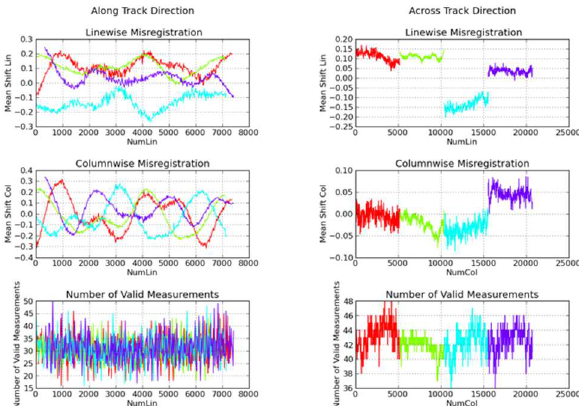
Figure 8 Misregistration profiles of FR-LQ1 image obtained with an attitude correction involving a 5 degrees polynomial function.